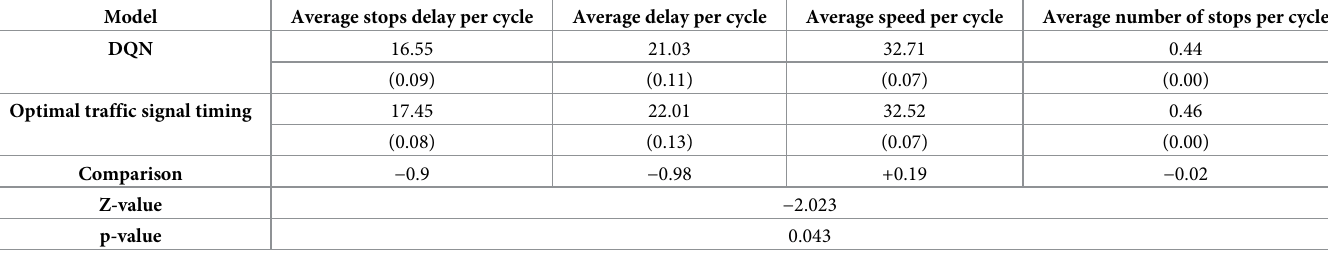
Table 4. Evaluation and validation results of scenario 1–3 in isolated